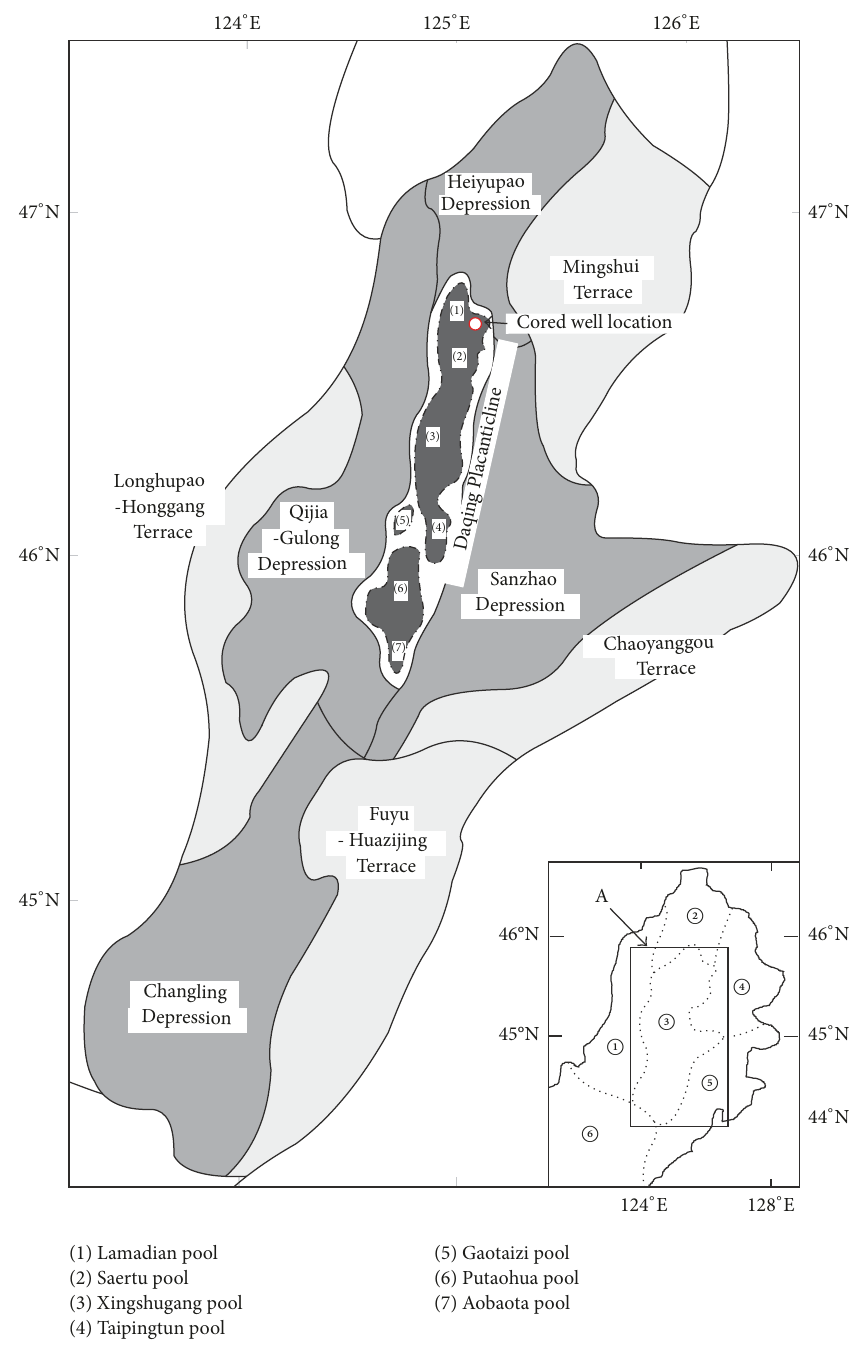
Figure 1: Structural outline map of the central depression zone: A-Location of the central depression zone in the Songliao Basin, A the western slope zone, B the northern plunge zone, C the central depression zone, D the northeastern uplift zone, E the southeastern uplift zone, and F the southwestern uplift